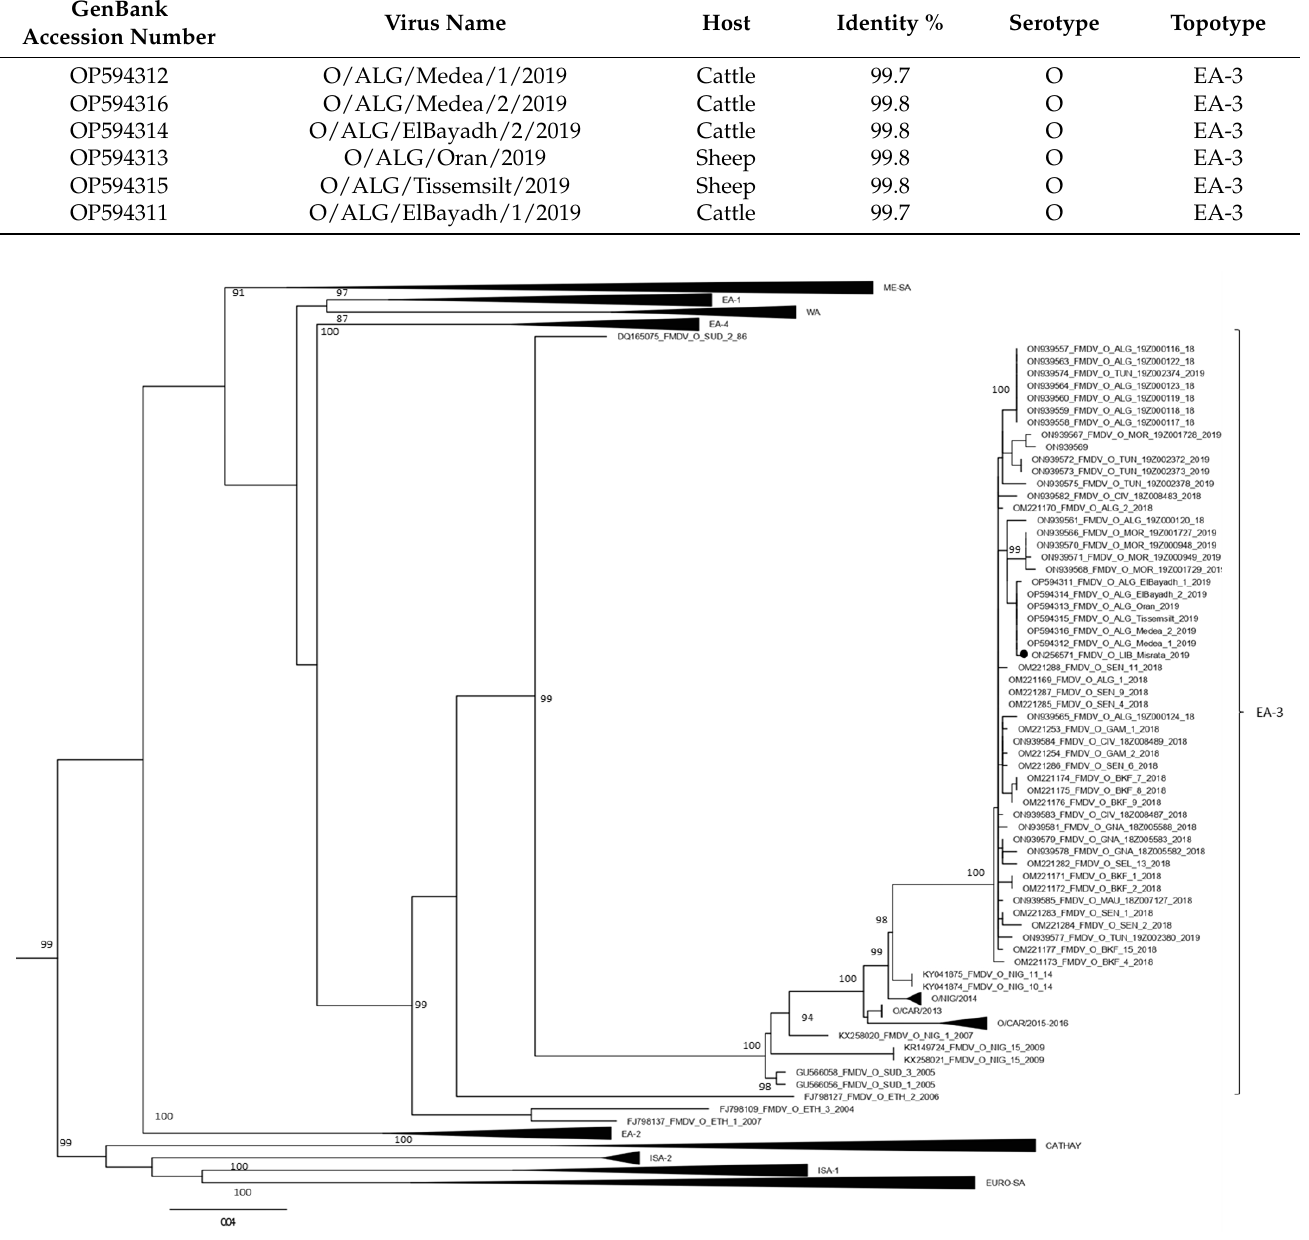
Figure 1. Maximum Likelihood phylogenetic tree showing the grouping of sequences from the 2018–2019 outbreak in the Maghreb within the O/EA-3 topotype. The sequence generated in this study is indicated with a black dot. Nodes bootstrap values major of 80 were indicated. The other topotypes within FMDV type O sequences are indicated. Sequences from Nigeria (NIG/2014) in-